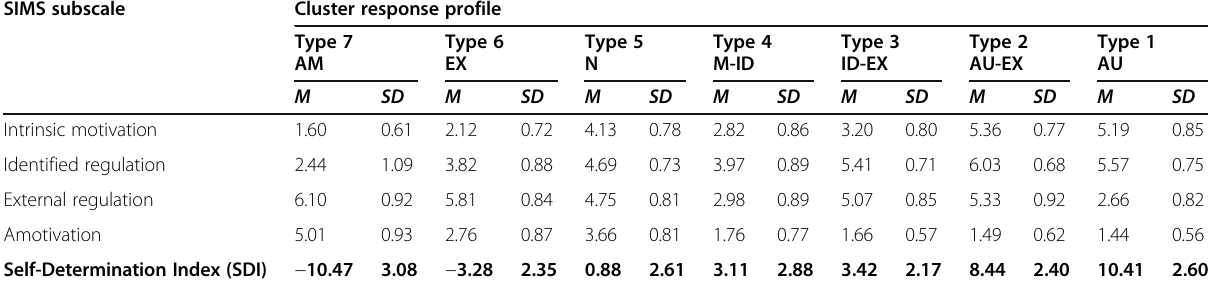
Table 4 Comparison of motivational response profiles (cluster centroids) based on SIMS subscale means and SDI values SIMS